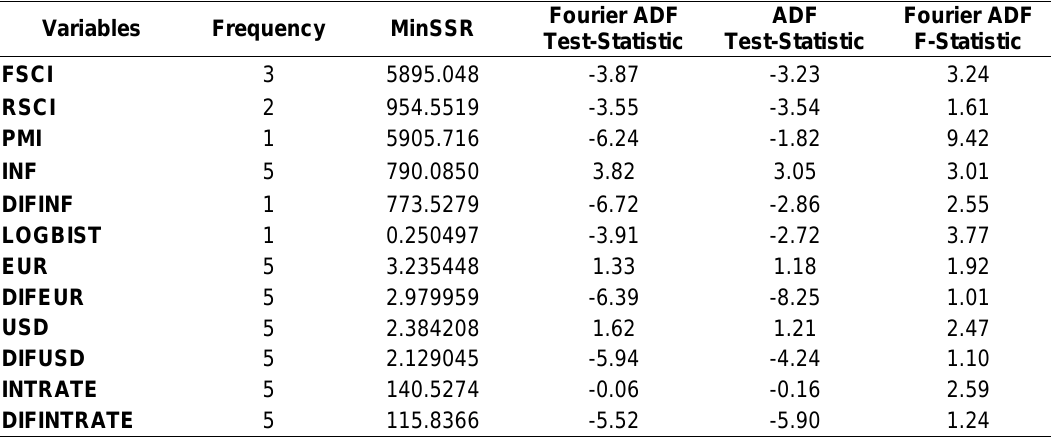
Table 4. ADF and Fourier ADF Unit root Test Results